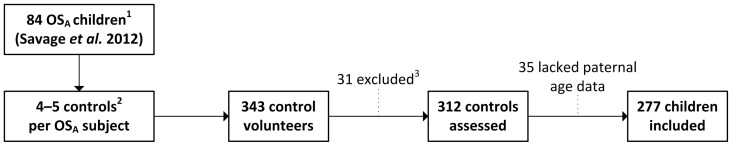
Summary of the study's recruitment process.
1 OSA children had been conceived via ovarian stimulation, and were examined in Savage et al.
[13]. 2 Controls were friends of OSA children to ensure similar age group, ethnicity, and socio-economic status. 3 22 children were born small-for-gestational age and/or premature; 5 were pubertal; 3 were born to a mother with gestational diabetes/glucose intolerance; and one child was on medication known to influence growth.